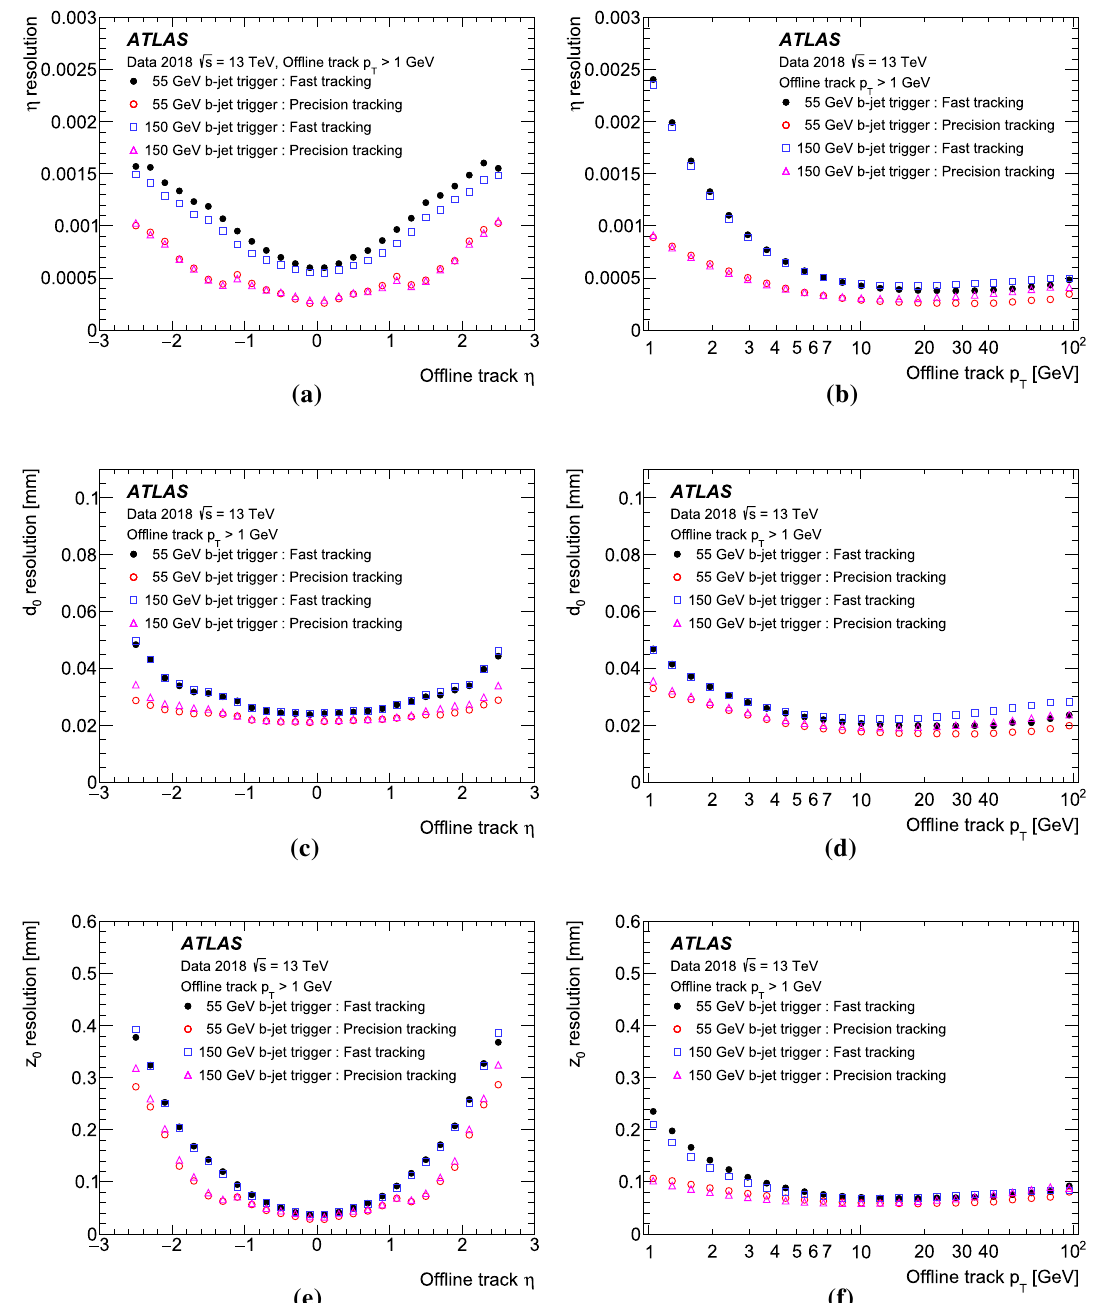
Fig. 38 The track resolutions for the fast and precision tracking from the second stage of the b -jet trigger for the 55GeV and 150GeV sig- natures. Shown are the resolutions for the trigger track pseudorapidity